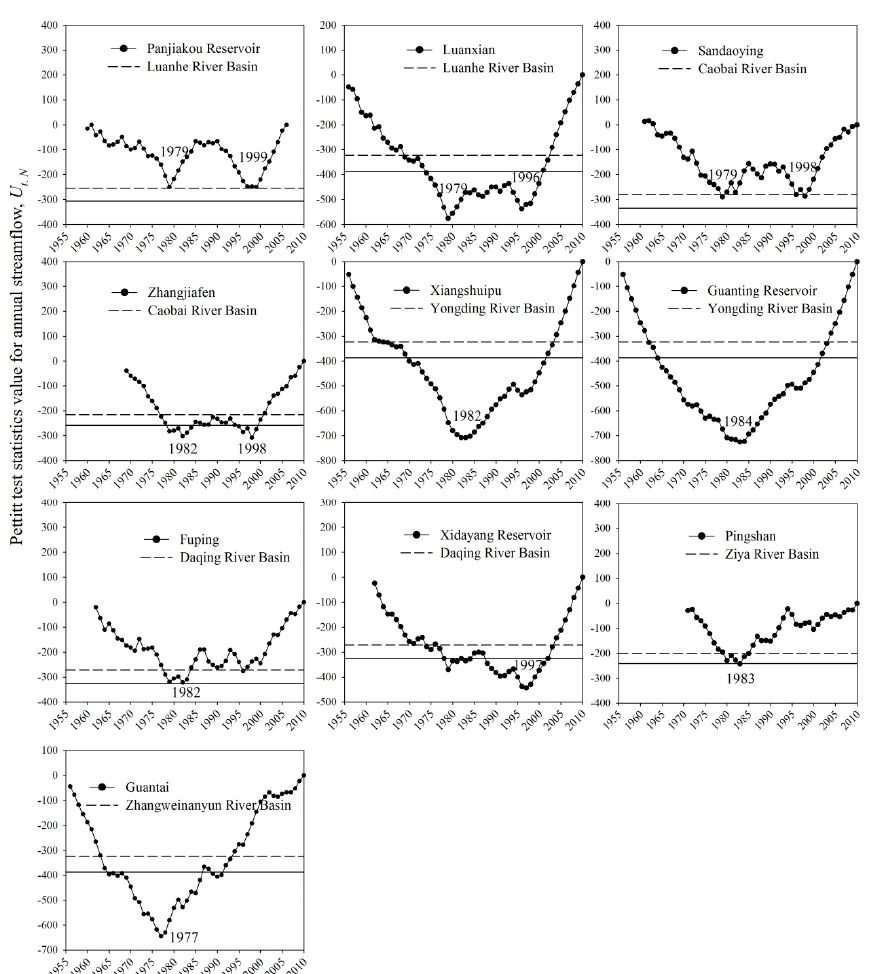
Figure 5. Abrupt change detection results of runoff in the six sub-basins of the Haihe River Basin.